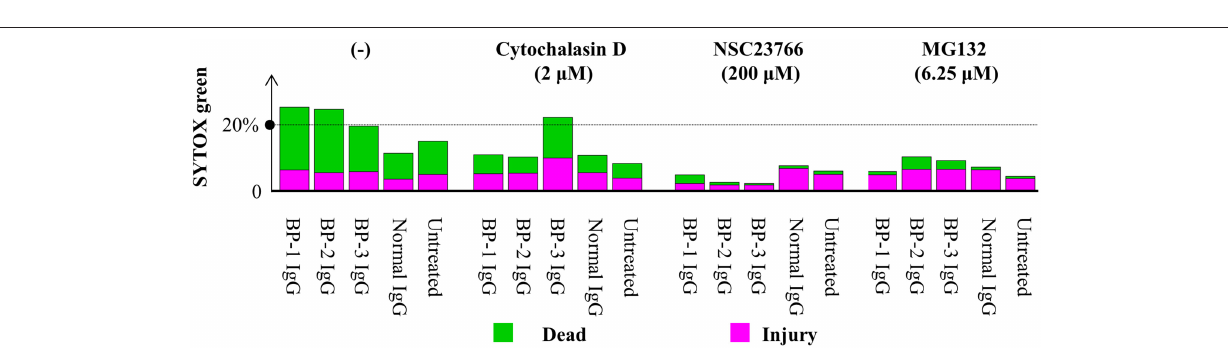
FIGURE 11 | Effects of cytochalasin D, NSC237766, and MG132 on the BP IgG-induced decrease in cellular metabolic activity. NHEKs were pretreated with cytochalasin D (2 µ M) for 30min, NSC23766 (200 µ M) for 1h, or MG132 (6.25 µ M) for 0h, and then 2 mg/ml BP IgGs (BP-1, BP-2, and BP-3) or normal IgG were added to the cultured cells for 16h. Then, NHEKs were collected, stained with SYTOX green (stains dead cells) and C 12 -resazurin (stains living cells), and analyzed using flow